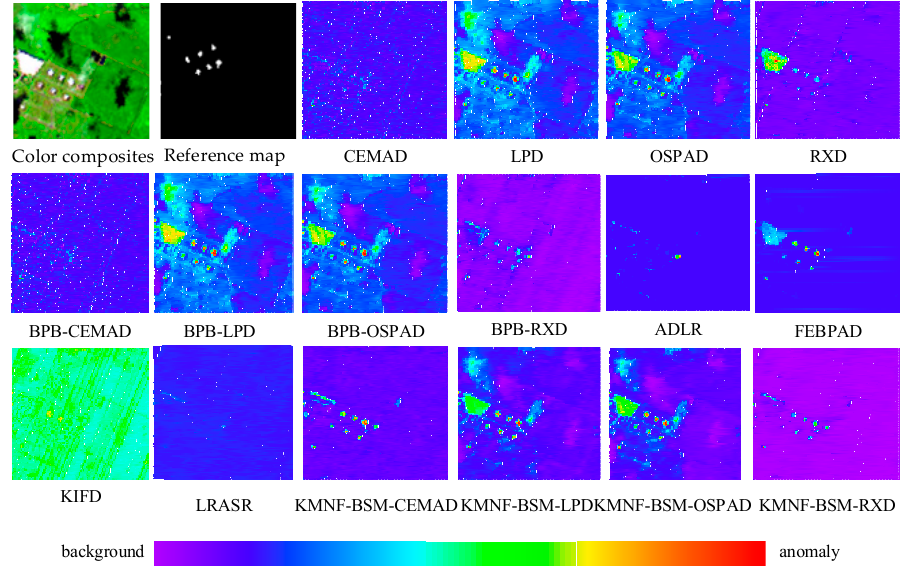
Figure 6. The detection maps of different detectors for the urban scene. In the detection maps of the vegetation scene in Figure 7, it can be seen that CEMAD, FEBPAD, KIFD, LRASR, KMNF-BSM-CEMAD, and KMNF-BSM-OSPAD have more uni- form backgrounds than other methods because the anomalous pixels occupy a tiny part of the entire image. The KMNF-BSM-RXD is relatively similar to RXD and BPB-RXD.